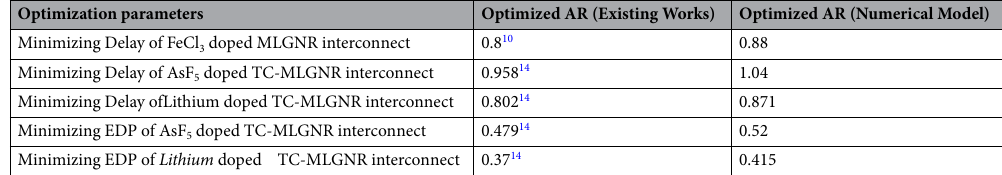
Table 3. Validation of our numerical model (section “Formulation and methodology”) with 10 and 14 .